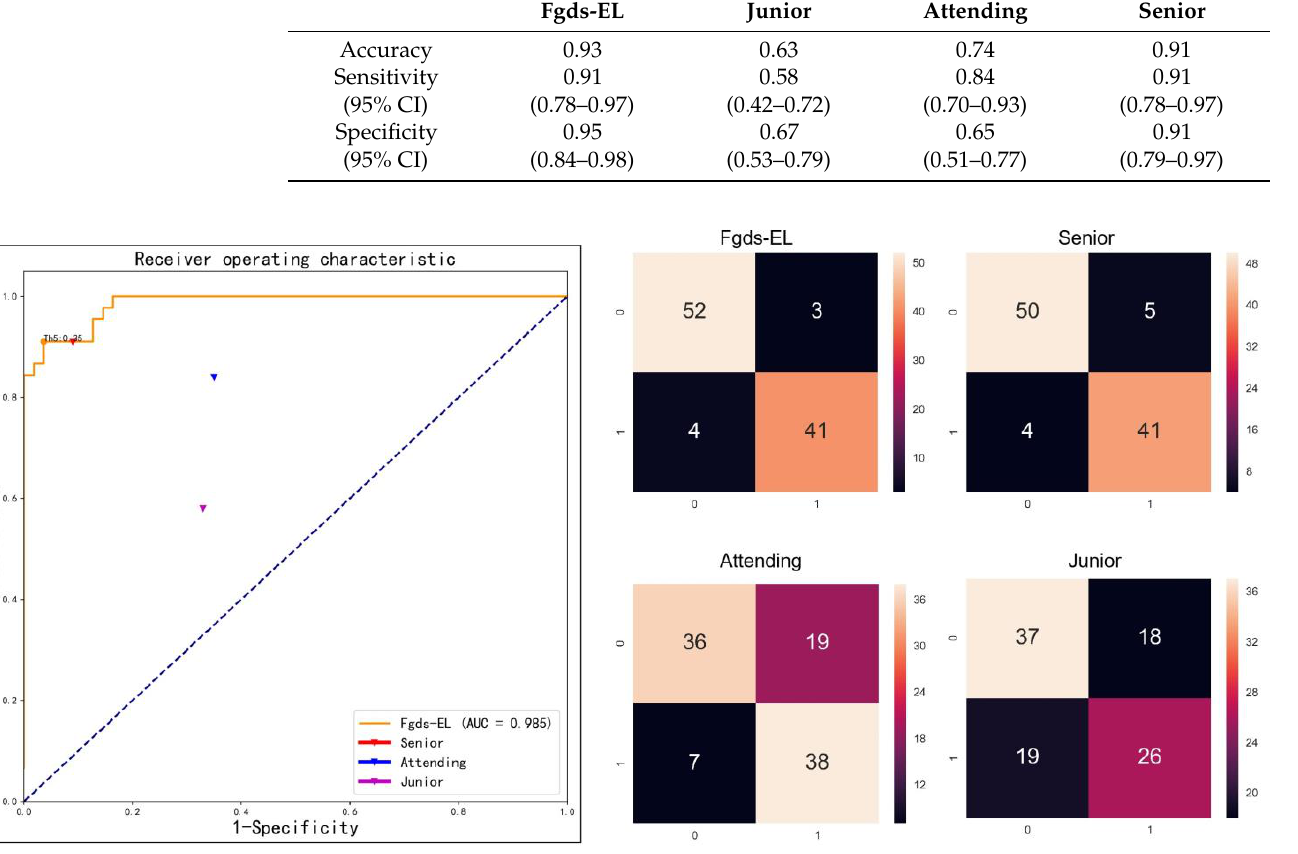
Figure 6. The ROC curves of the Fgds-EL and confusion matrix for screening for genetic diseases on the test set with three levels of sonographer performance (junior, attending, and senior) to compare. In the confusion matrix, the horizontal coordinate is the predicted label, and the vertical coordinate is the true label.